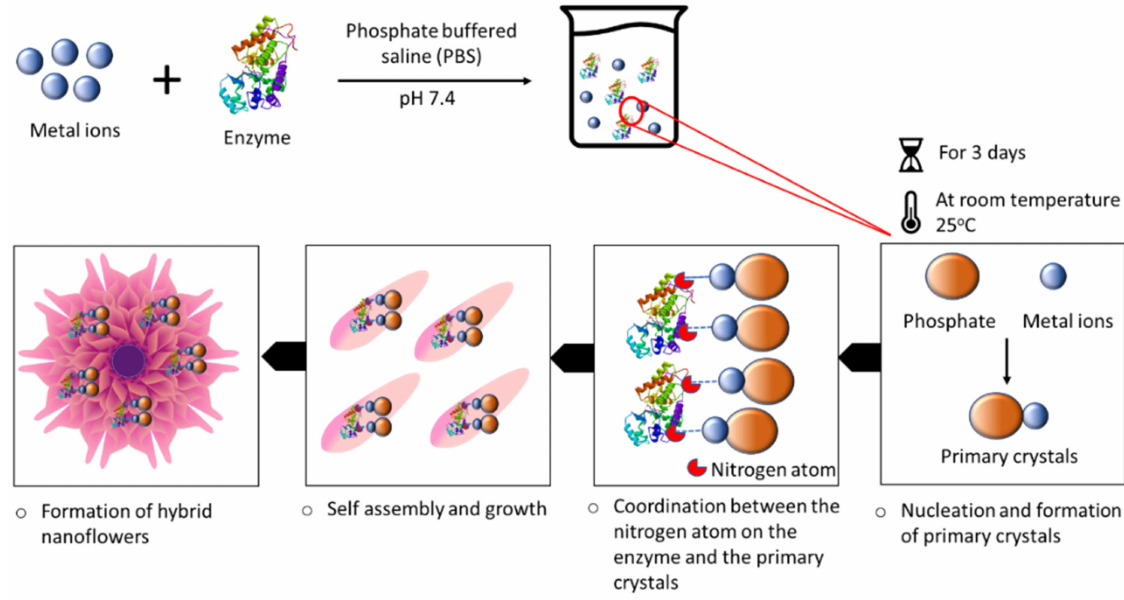
Figure 1. Schematic illustration of the hybrid nanoflower (hNF) formation process.